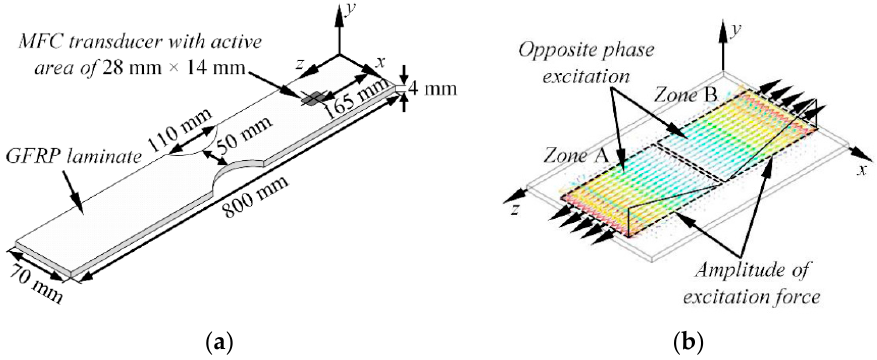
Figure 6. The schematic view of the GFRP plate used in FE simulations ( a ), the principle of guided wave generation in the FE model simulating the d 33 mode of MFC transducer ( b ).